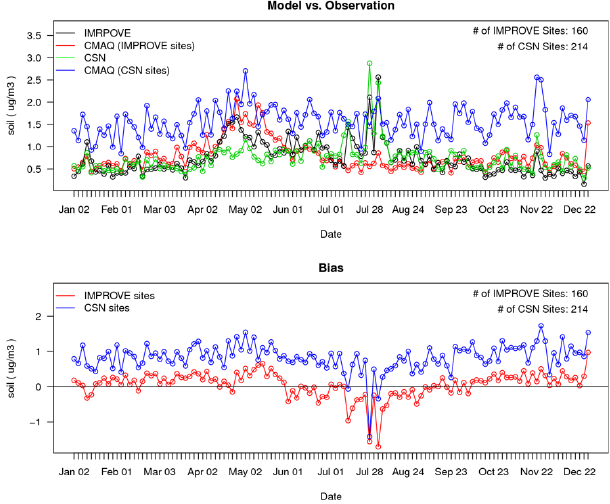
Fig. 1. The top time series plot shows the IMPROVE fine particu- late soil observations (black) versus CMAQ estimated soil (red) and CSN soil observations (green) versus CMAQ estimated soil (blue) for 2006 for all CONUS sites. The bottom time series plot shows the CMAQ bias for soil at the IMPROVE network sites (red) and CSN sites (blue). Both plots are in units of µgm − 3